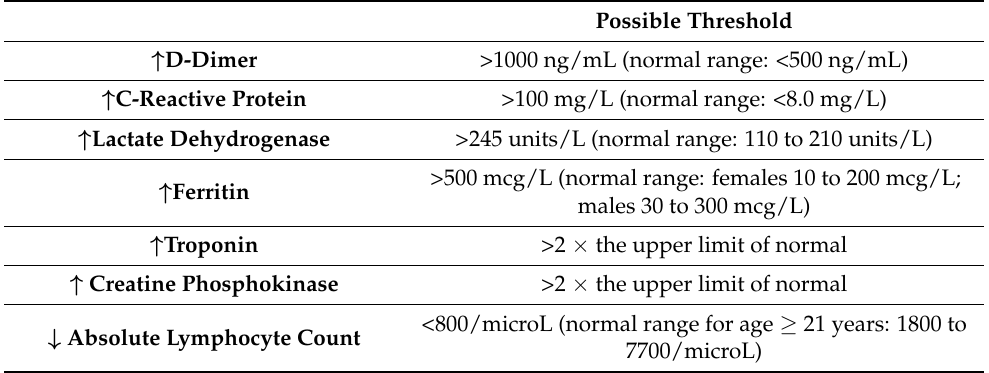
Table 1. Laboratory features associated with severe